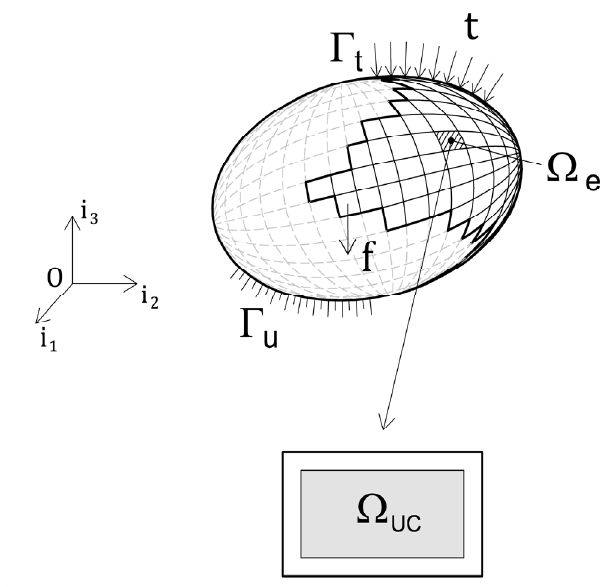
Figure 2: Mechanical scheme of the CH